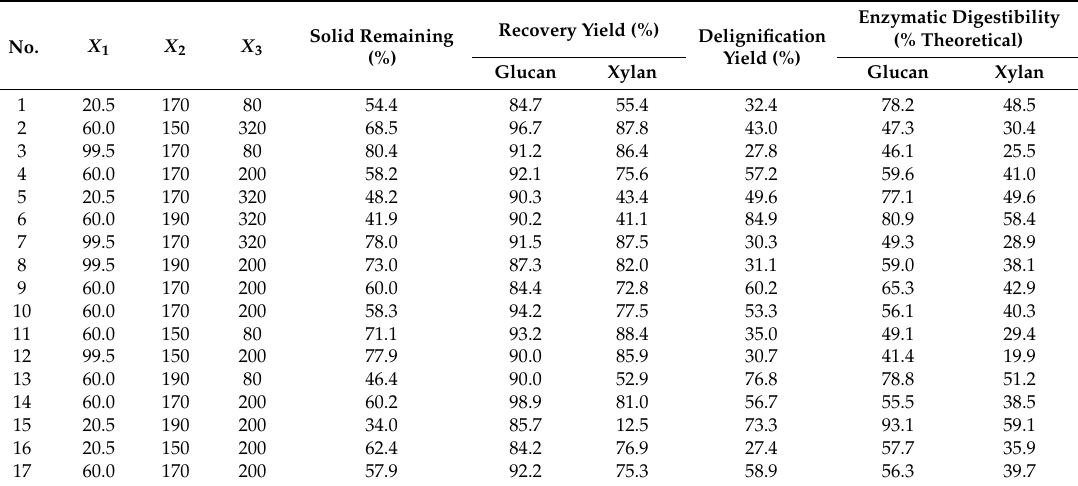
Table 2. RSM result conditions for organosolv